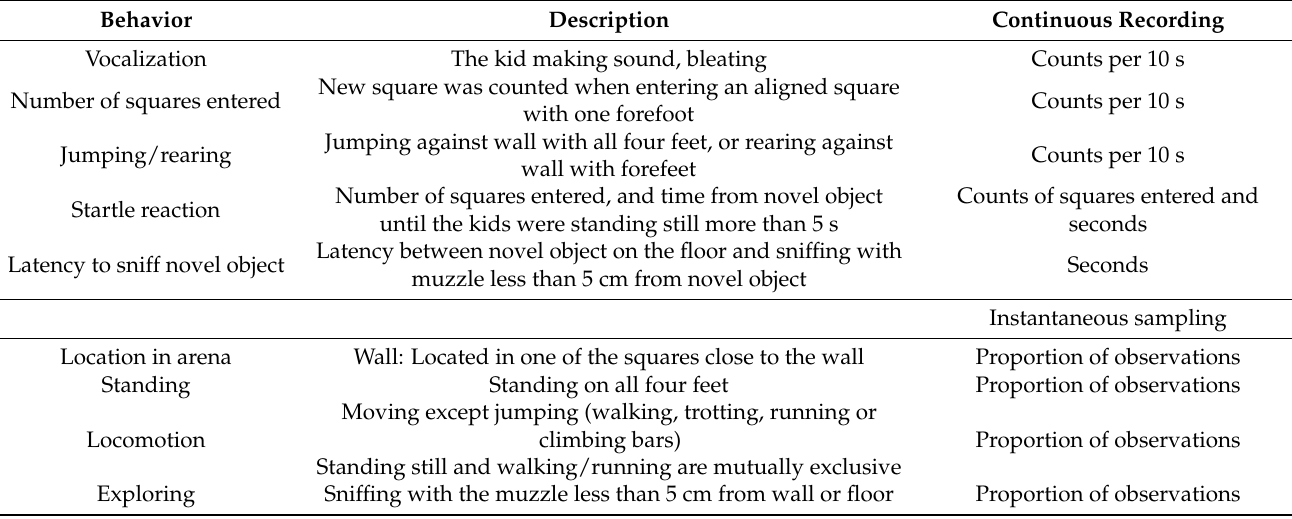
Table 2. Definitions of observed behaviors in kids, during an isolation test at two weeks and two months of age, and during an arena test at two months of